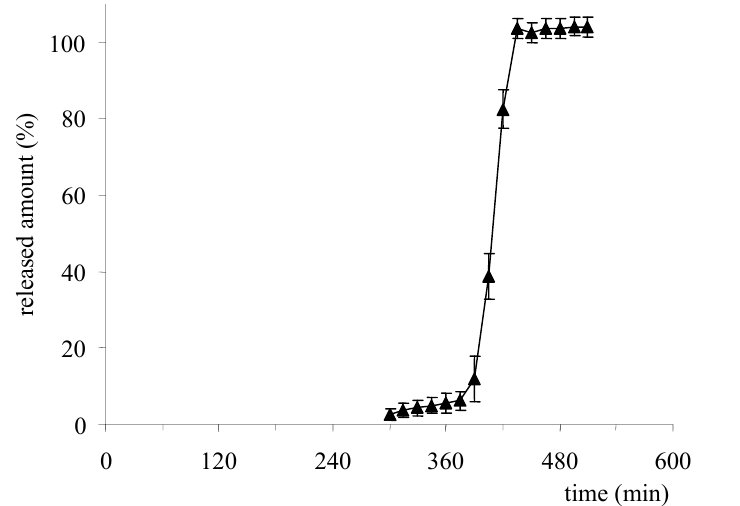
Figure 15. Release profile of verapamil from a Chronotopic ® press-coated system having 150% weight gain. Reprinted with permission from Ref. [58]. 2009, John Wiley & Sons.